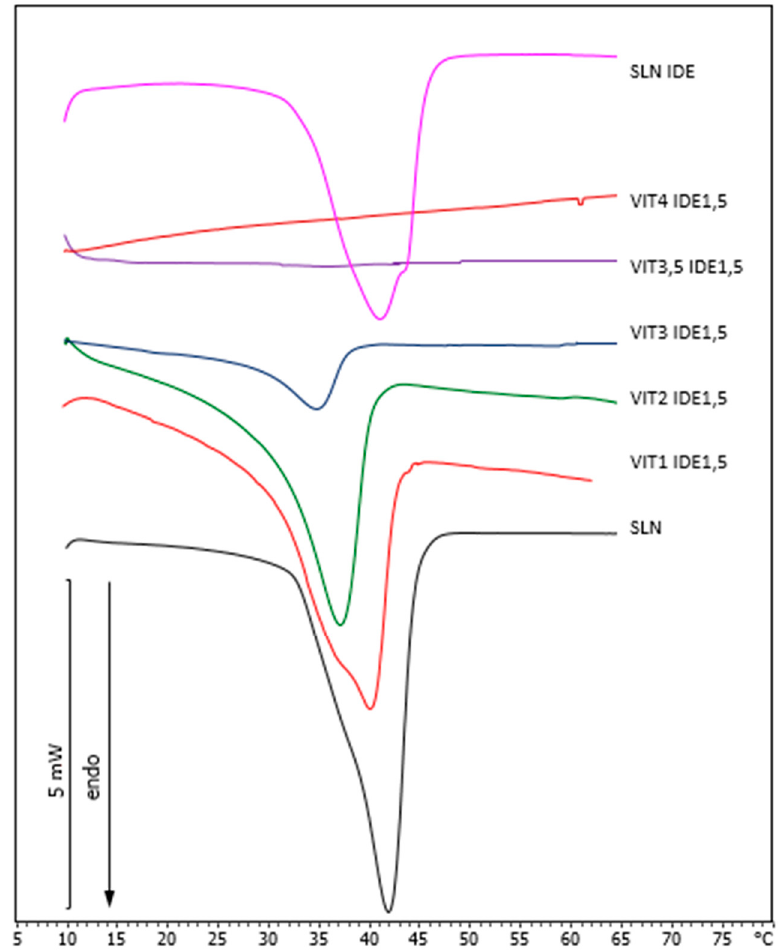
Figure 7. DSC curves of unloaded and IDE-loaded SLN, NLC loaded with IDE 1.5% w / w .